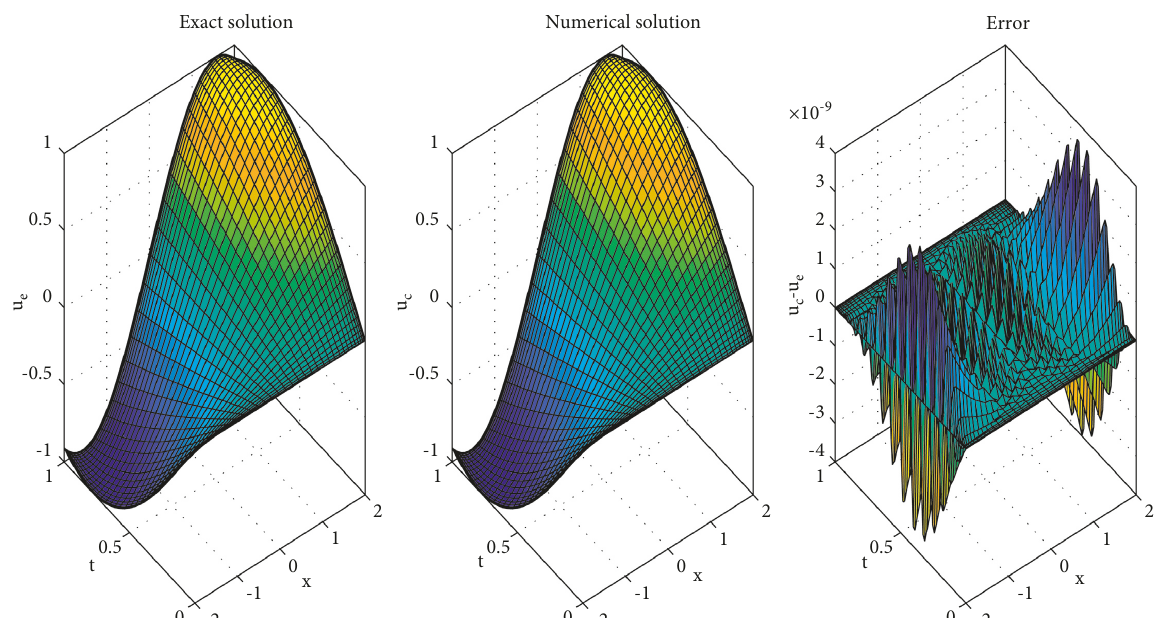
Figure 3: Exact solution, numerical solution, and error of Example 3 ( m � n � 40 ,d